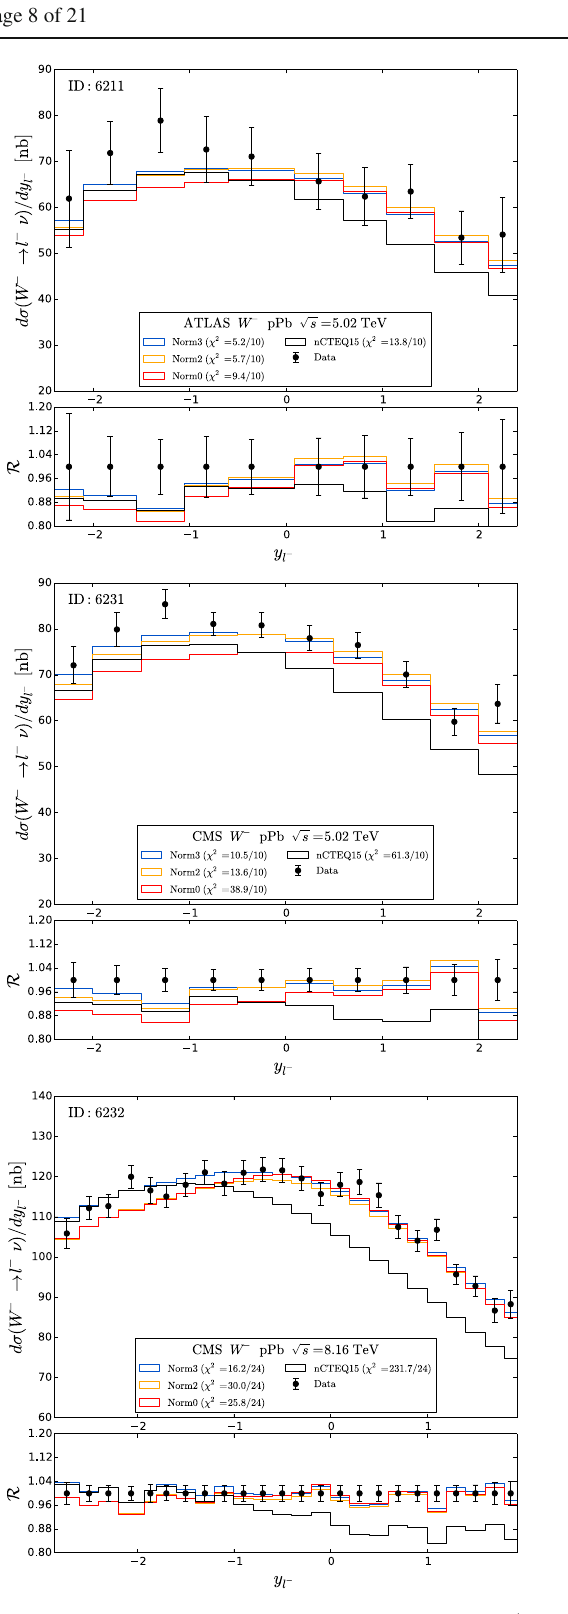
tered. For reference, ATLAS Run I { W − , W + } = { 6211 , 6213 } , CMS Run I { W − , W + } = { 6231 , 6233 } and CMS Run I { W − , W + } = { 6232 , 6234